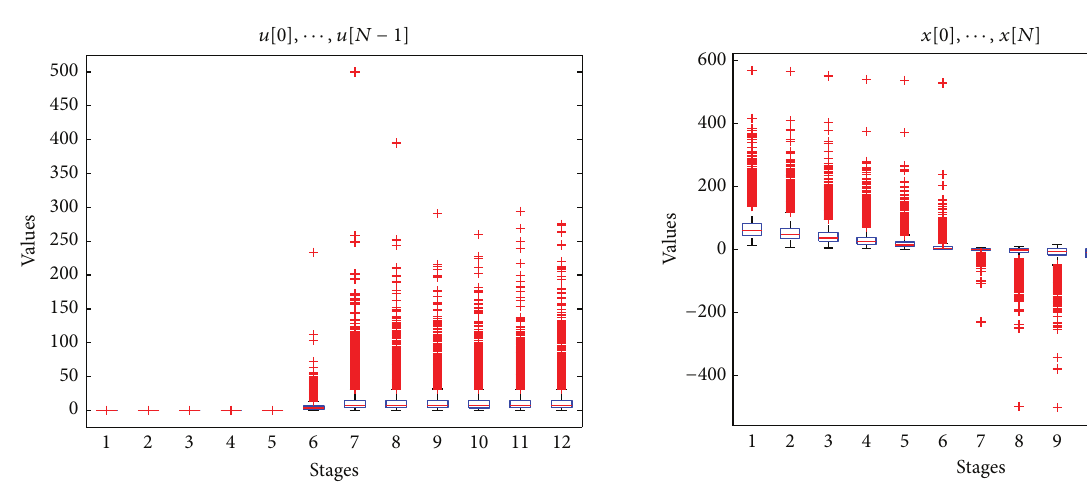
Figure 11: Case 3, box-plots of the optimal orders.